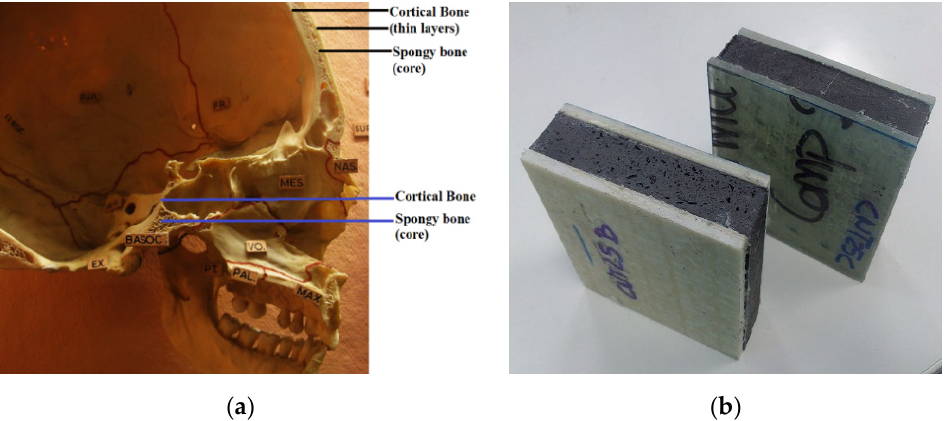
Figure 2. ( a ) Human skull a nature’s design of sandwich structure for energy absorption. (Source of image: “Human Skull” by Quasimondo is licensed under CC BY-NC 2.0) ( b ) Example of sandwich panel (Source of image: “NANOCORE sandwich panel with MWCTs” by JavierACCIONA is licensed under CC BY-NC 3.0).